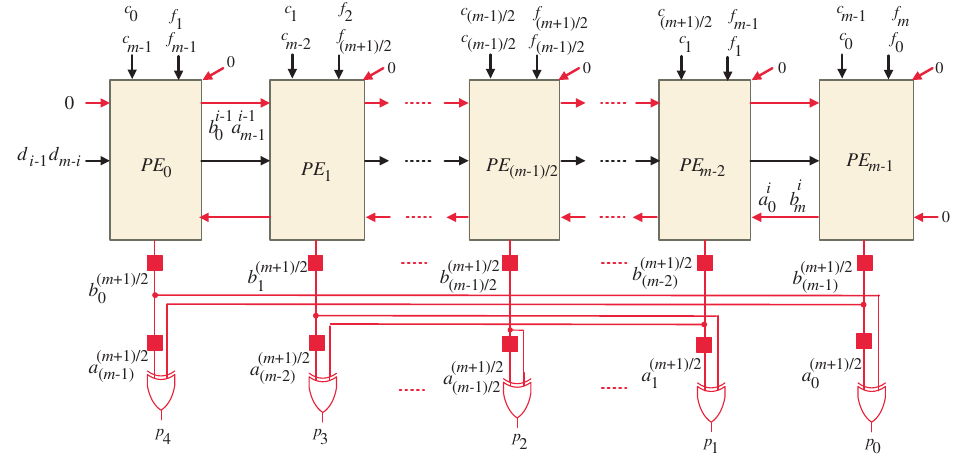
Figure 3. Semi-systolic bit-parallel multiplier